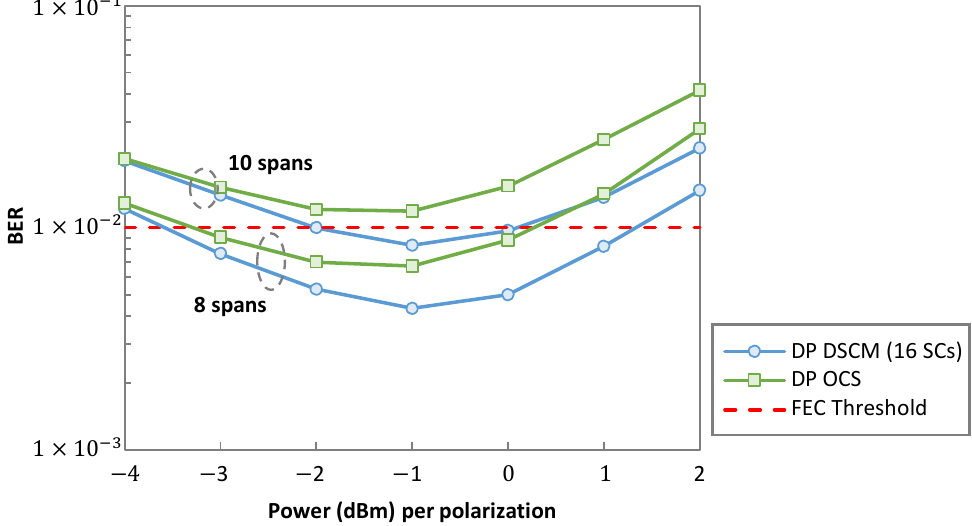
Figure 6. Spectrum of the single carrier signal used for OCS ( a ) and 16 SC DSCM ( b ).